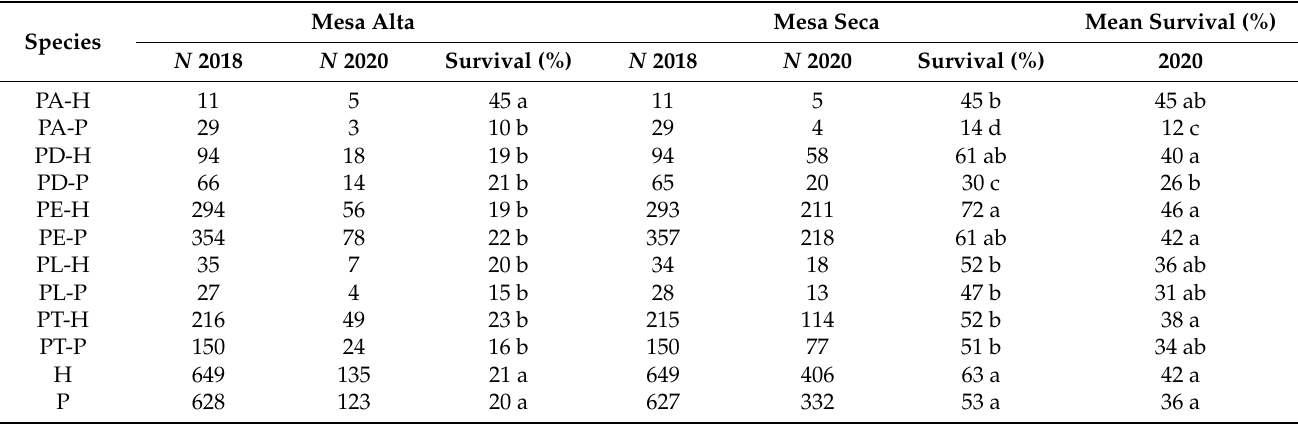
Table 5. Number of Pinus seedlings ( N ) growing in the field in both provenance trials, between July 2018 and October 2020 (classified as hybrids and pure species). Different letters in each survival column indicate significant differences in the survival